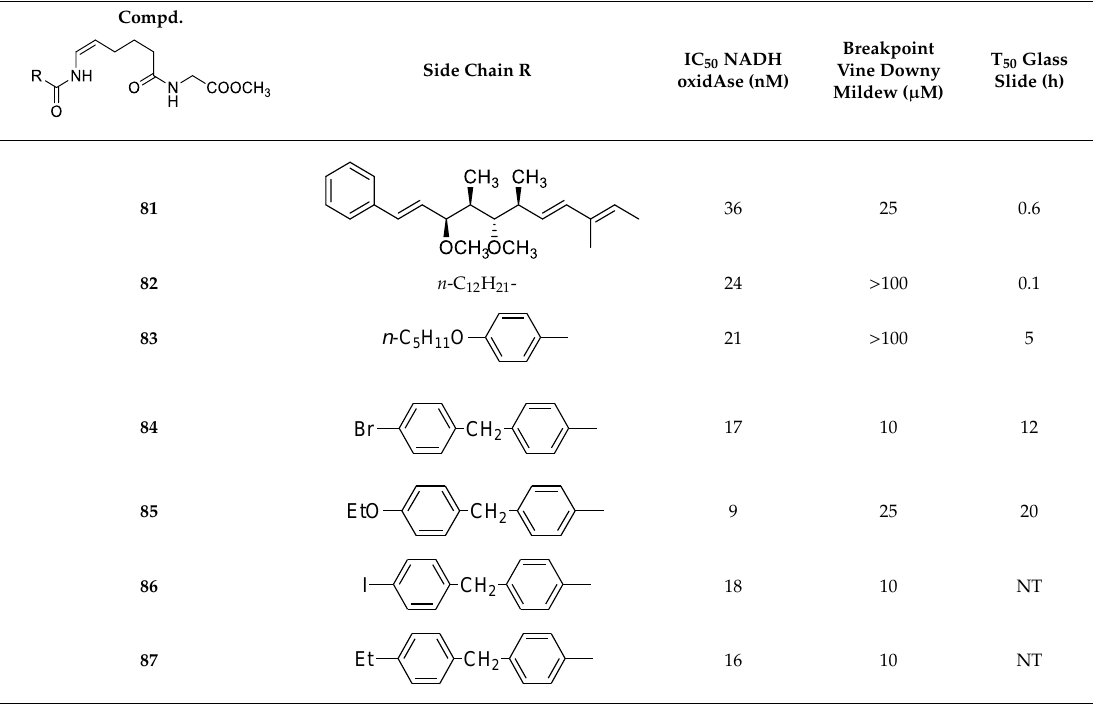
Table 9. Activity of crocacin analogues on NADH oxidase and vine downy mildew on plants. Compd.